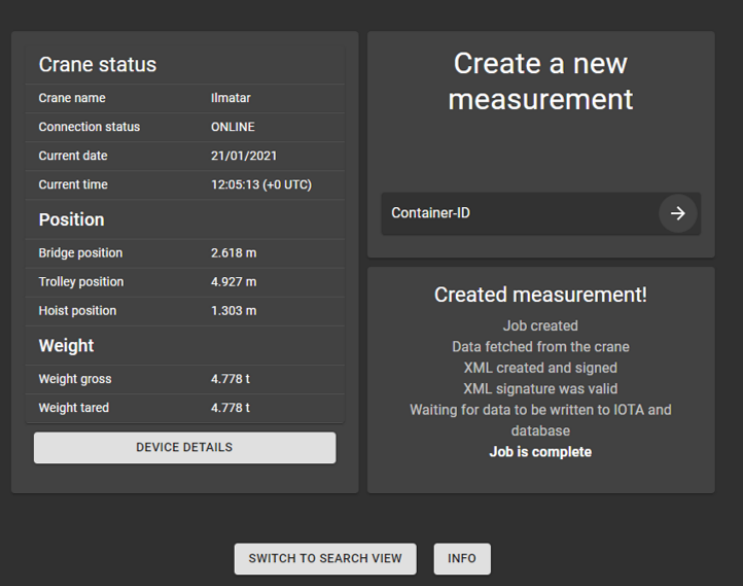
Figure 3. The operator view of the UI showing that a measurement has been successfully sent to IOTA and saved into the database.